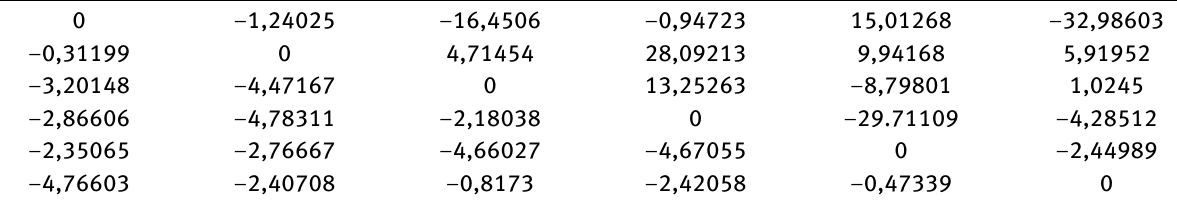
Table 2: Asymmetric weight coeflcients of neural network (case 2)